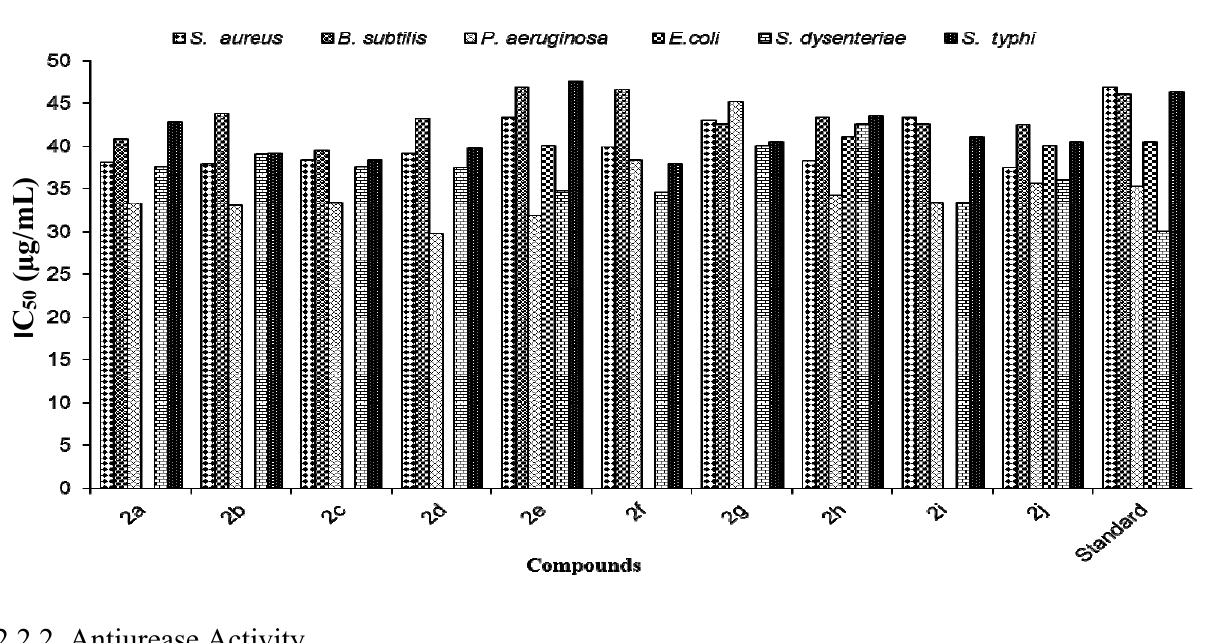
values of antibacterial Figure 1. IC 50